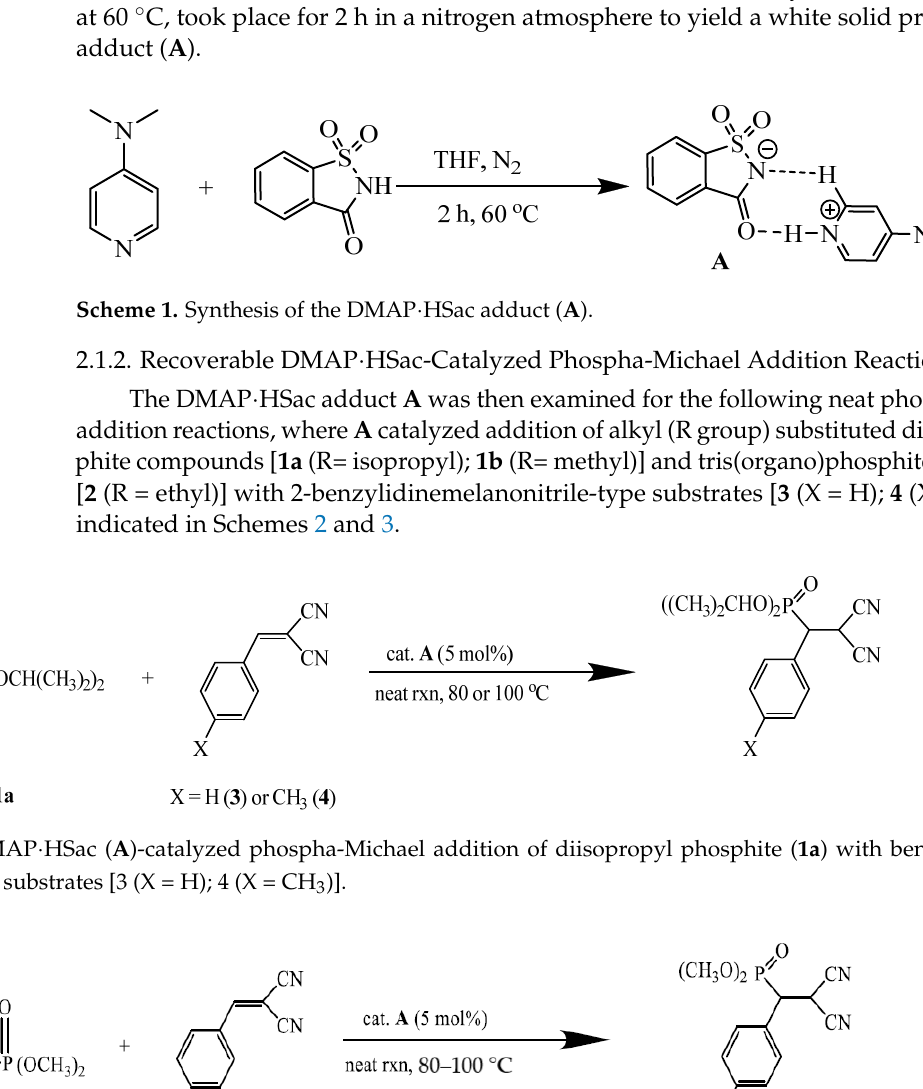
Table 1. Recycling results of A -catalyzed phospha-Michael addition of diisopropyl phosphite ( 1a ) with benzylidenemalononitrile ( 3 ) at 80 °C.